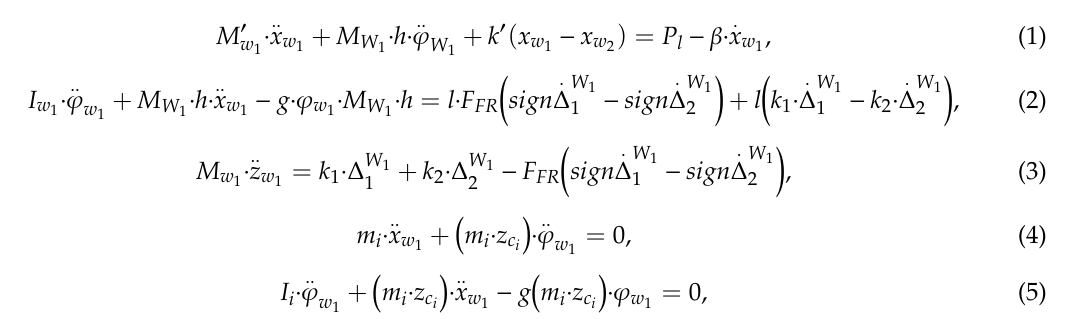
Figure 5. Design diagram of an articulated flat wagon.